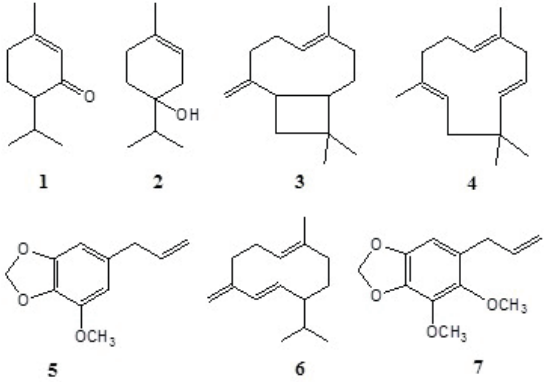
Figure 1 - Chemical structures of major constituents identified in the essential oils from P. aduncum inflorescences and leaves: piperitone ( 1 ), terpinen-4-ol ( 2 ), β-caryophyllene ( 3